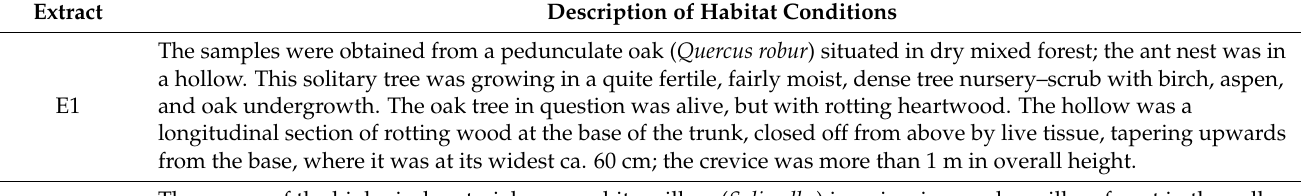
Table 3. Description of the habitat conditions of the ant nests used as the source of biological material for extracts E1–E6. Extract Description of Habitat Conditions